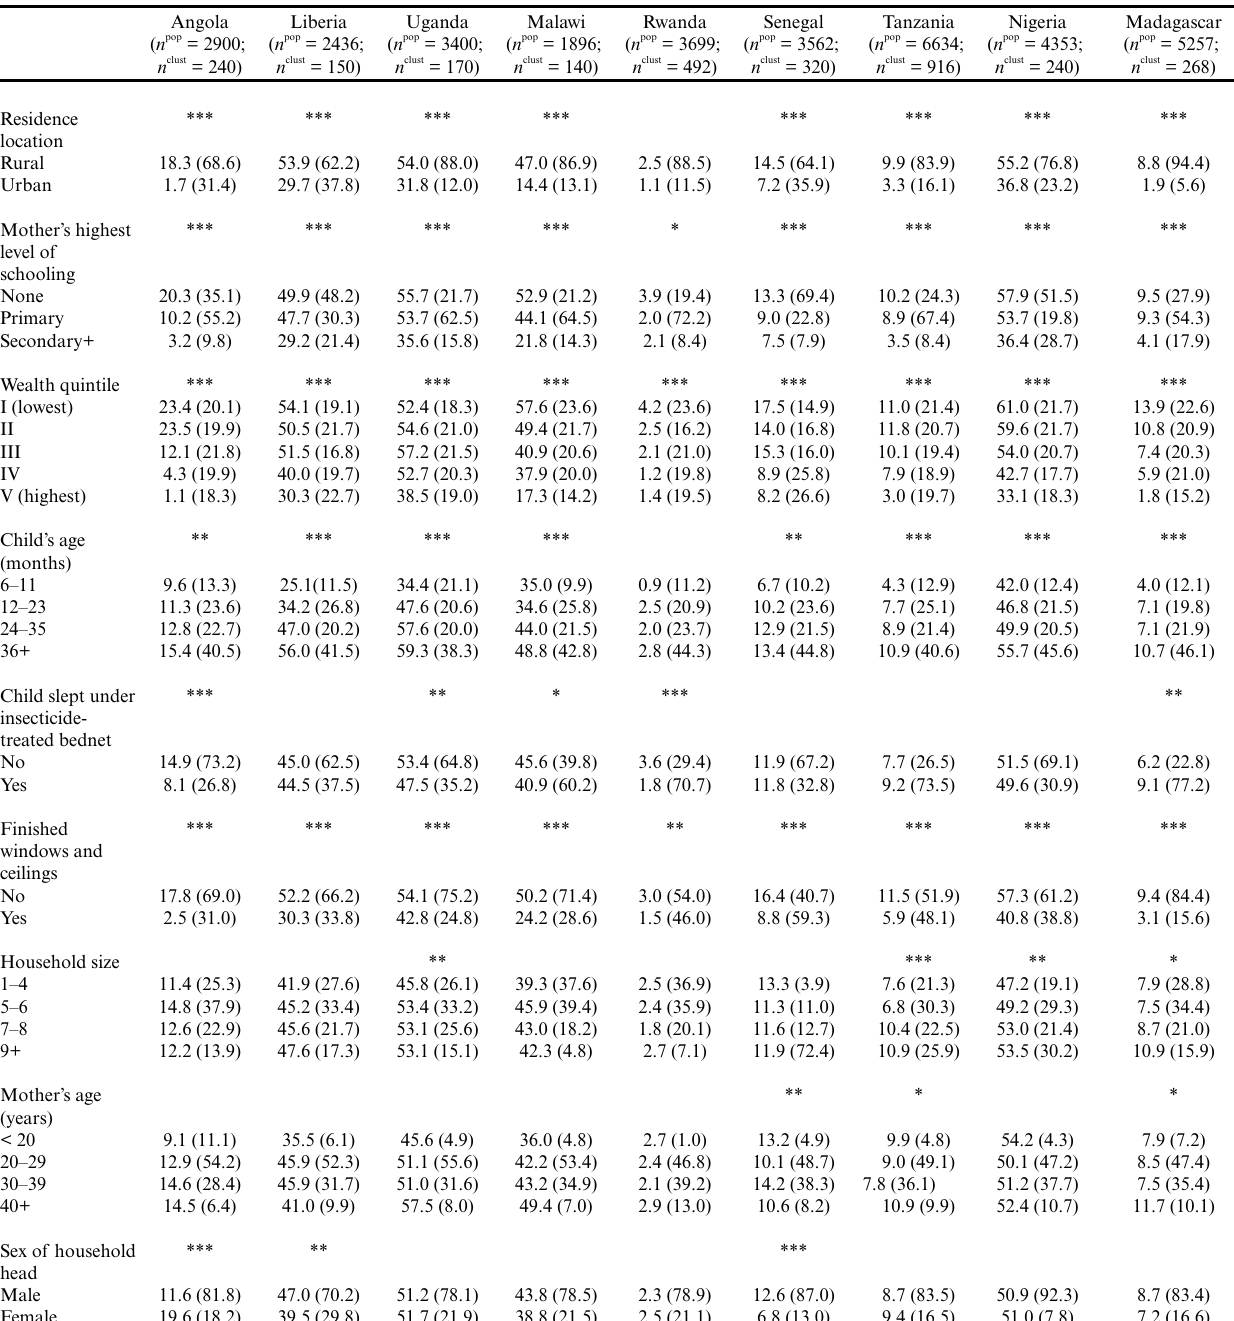
Madagascar ( n pop =